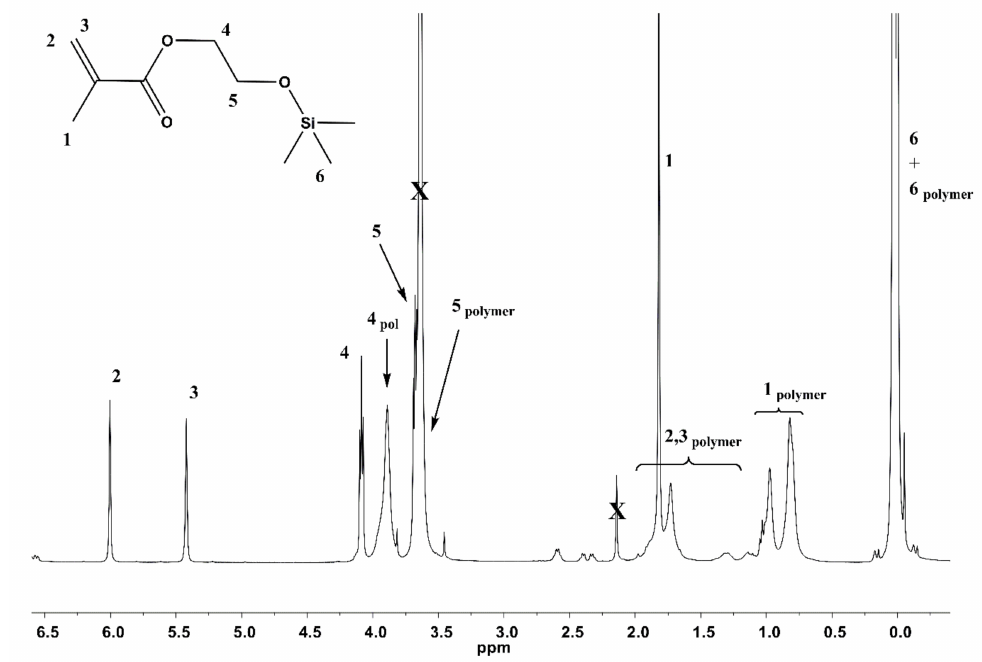
Figure 1. Representative 1 H NMR spectrum from filtered polymerization mixture of poly(2-(trimethylsilyloxy)ethyl methacrylate)